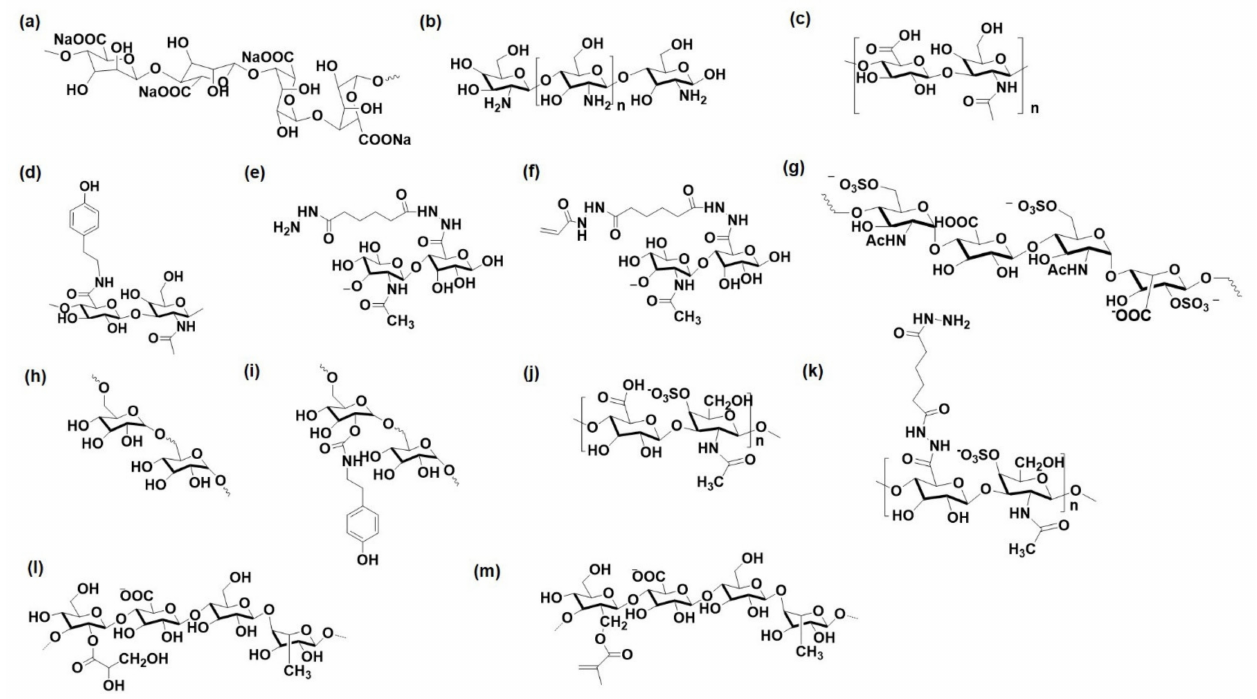
Figure 3. Chemical structures of polysaccharide polymers: ( a ) alginate (sodium salt), ( b ) chitosan, ( c ) hyaluronic acid (HA) and their modifications such as ( d ) HA–tyramine, ( e ) HA–adipic acid dihydrazide, ( f ) HA–acrylate, ( g ) heparin, ( h ) dextran and its ( i ) tyramine conjugate, ( j ) chondroitin sulfate and its modification, ( k ) chondroitin sulfate–hydrazide, and ( l ) gellan gum and its ( m ) methacrylate